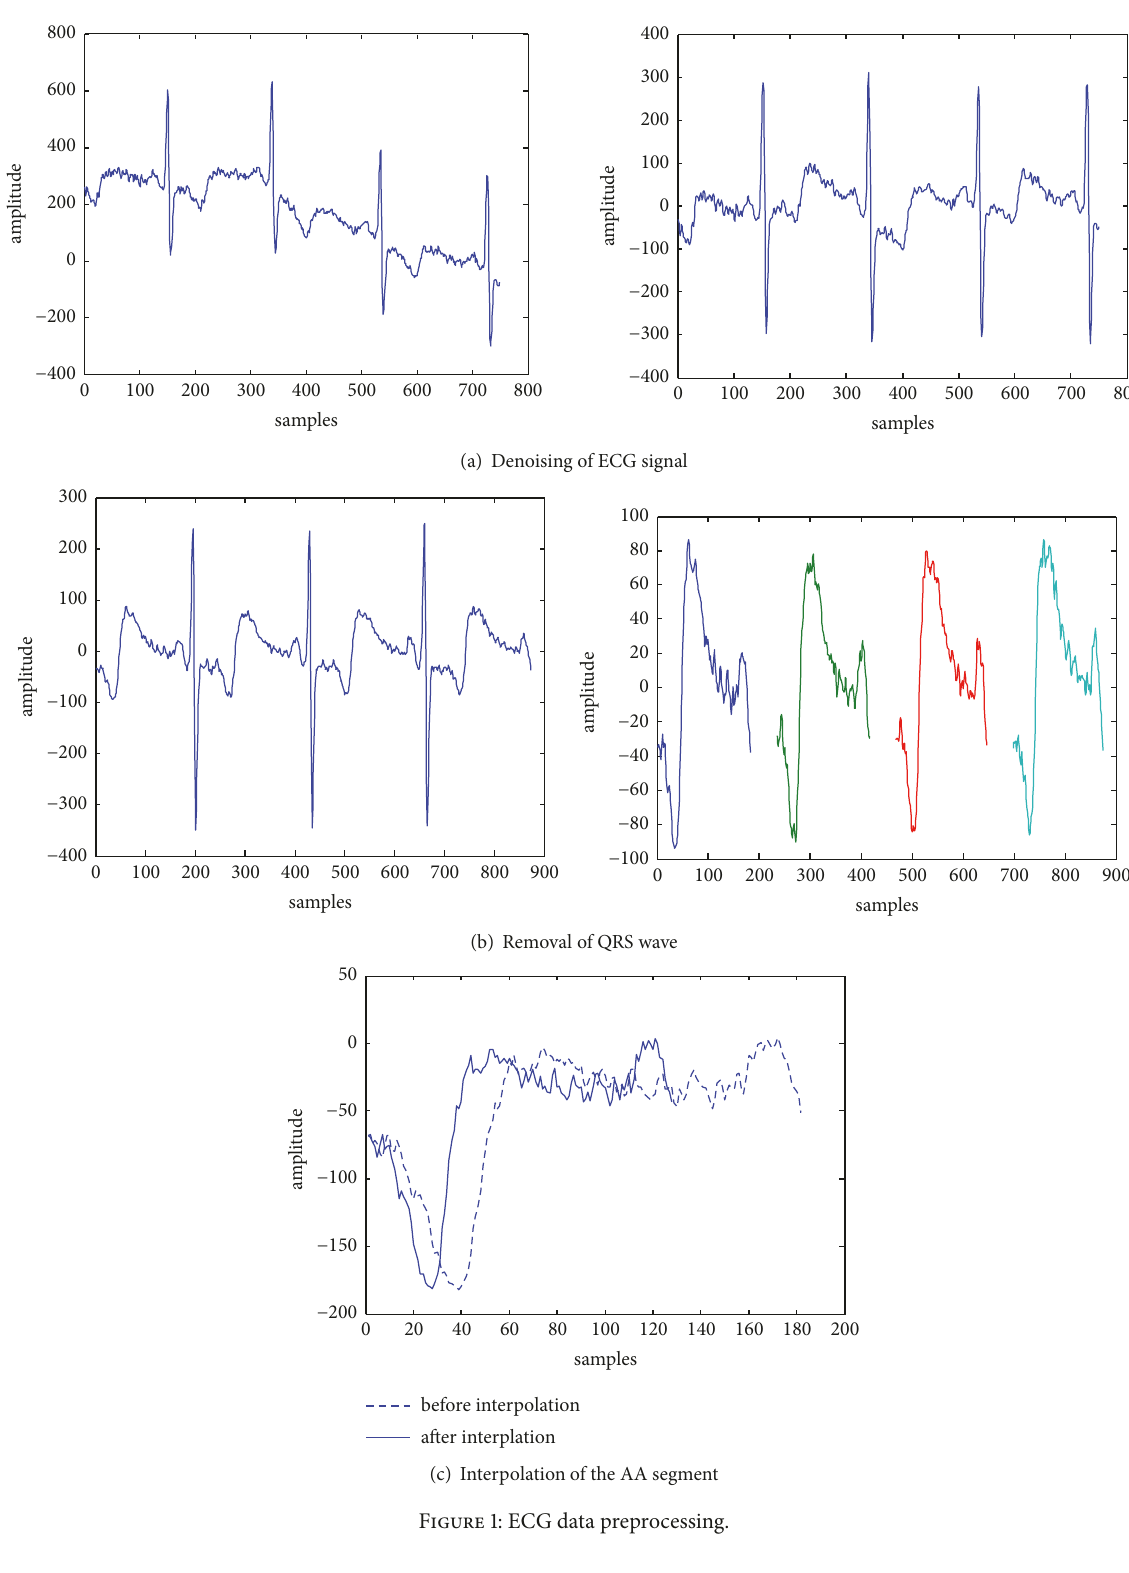
Figure 1: ECG data